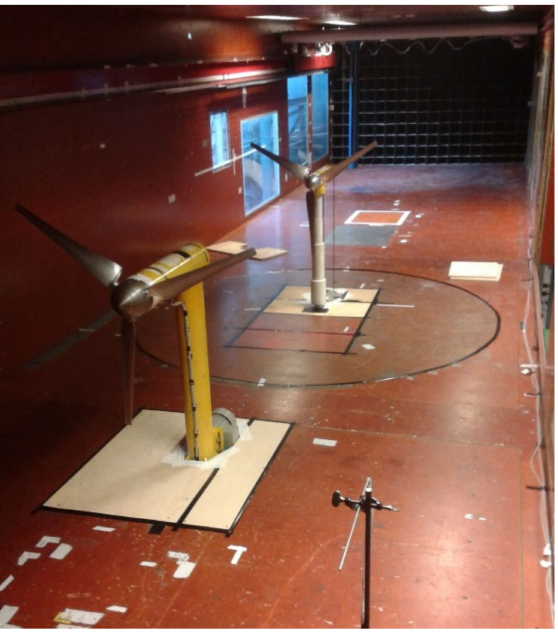
Figure 3. NTNU wind tunnel test section with two tested wind